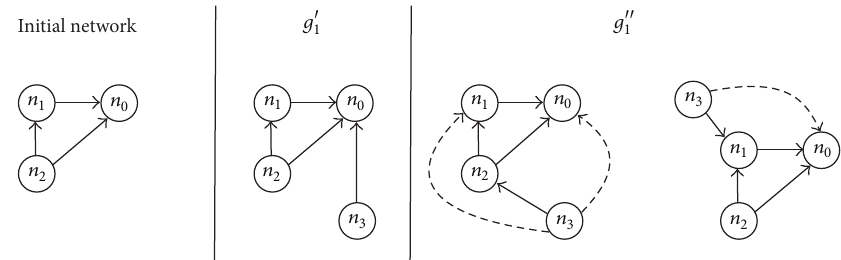
Figure 2: A network comprising three nodes ( 𝑛 0 , 𝑛 1 , 𝑛 2 ). In this network, the in-neighbors of 𝑛 0 are 𝑛 1 and 𝑛 2 . Also the number of nodes with three incoming links is 𝑄 3 = 0 . There are two possible ways to increase 𝑄 3 : ( 1 ) a new node 𝑛 3 randomly selects node 𝑛 0 and connects to it ( 𝑔 󸀠 1 in the figure and (15)); thus 𝑄 3 = 1 ; ( 2 ) a new node 𝑛 3 randomly selects an in-neighbor of 𝑛 0 and connects to it (solid line) and to 𝑛 0 (dashed line), as stated by 𝑔 󸀠󸀠 1 in (15) and this